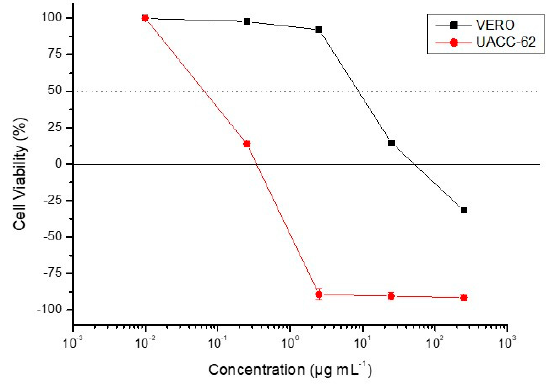
Figure 2. E ff ect of 6-methoxycoelonin ( 4 ) [0.25, 2.5, 25, and 250 µ g mL − 1 ] on cell viability in UACC-62 Figure 2. Effect of 6-methoxycoelonin ( 4 ) [0.25, 2.5, 25, and 250 µg mL − 1 ] on cell viability in UACC-62 human melanoma and VERO nonneoplastic cell human melanoma and VERO nonneoplastic cell lines.